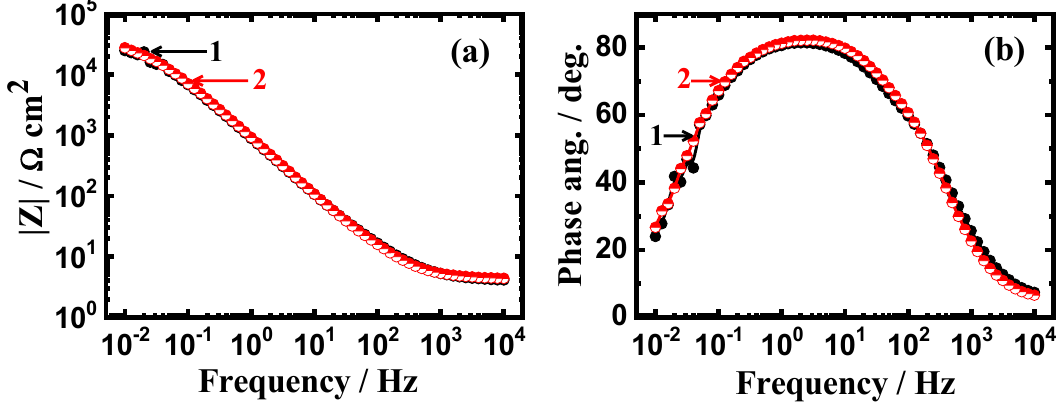
Figure 8. Change of ( a ) | Z | and ( b ) Φ with frequency plots obtained for (1) API-2H steel and (2) 75%Cr 3 C 2 − 25%NiCr coated API-2H steel after their immersion in 4% NaCl solution for 1 h.